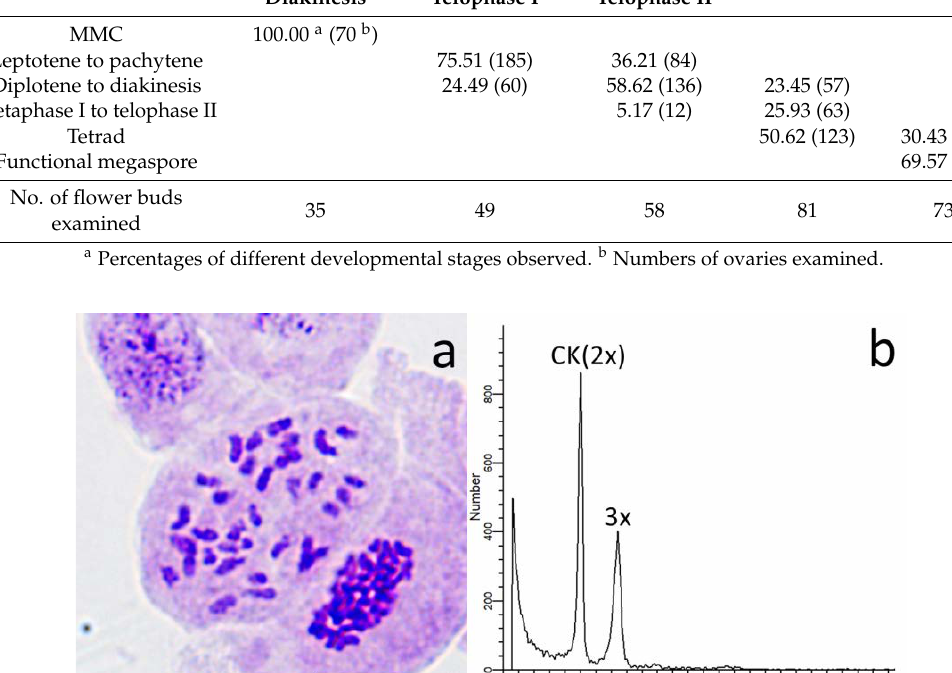
Table 2. Relationship between microsporogenesis and megasporogenesis in Eucalyptus urophylla . Developmental Stage of